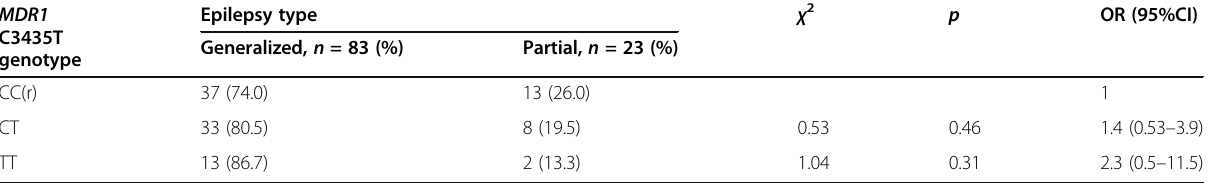
Table 4 Association between MDR1 C3435T genotype and epilepsy types (generalized and partial) MDR1 C3435T genotype